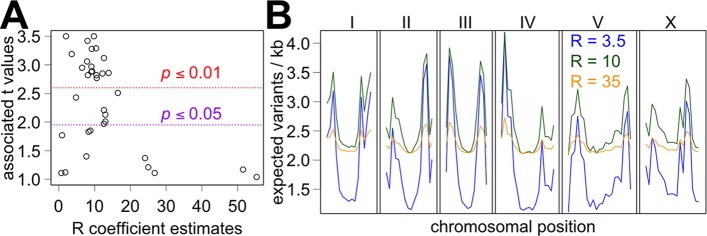
The best estimates of the R coefficient and the implications of R coefficient in the generation of skewed variant distribution.(A) The R coefficient estimates with the highest confidence as indicated by the associated t values of > 1. Possible cutoffs using p < 0.05 (purple) and p < 0.01 (red) are indicated by colored dotted lines. (B) Expected variant distribution by chromosomal pattern assuming an R coefficient value of 3.5 (blue), 10 (green), and 35 (orange). The presumed M * d values are 300, 205, and 60, respectively, for R coefficient values of 6, 10, and 60.